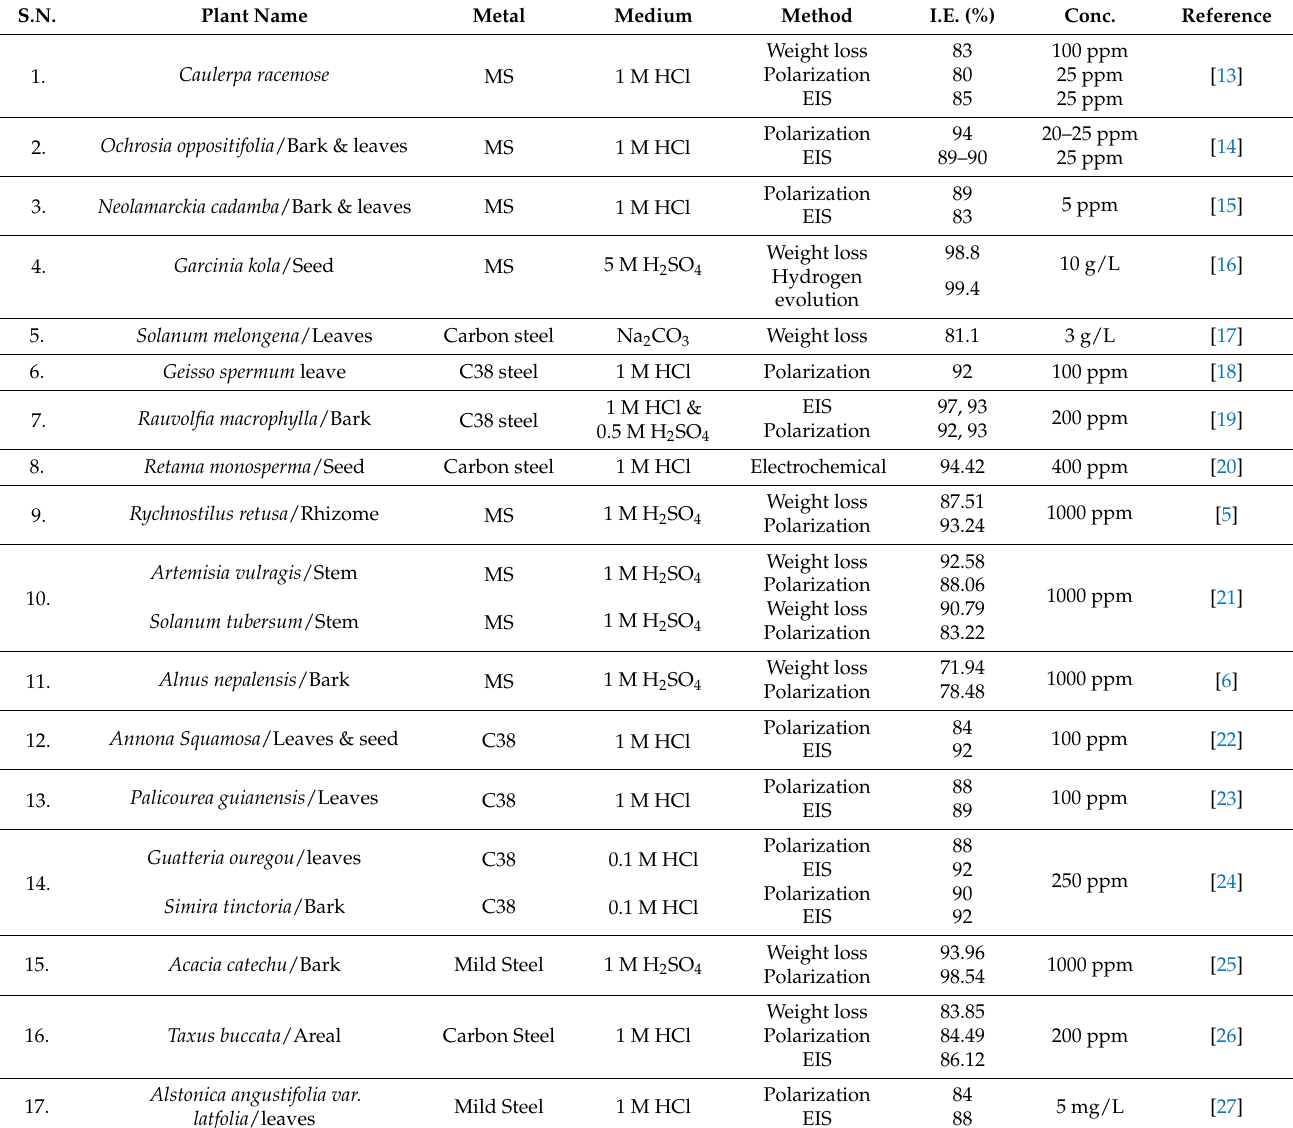
Table 1. Plants and their alkaloids as green corrosion